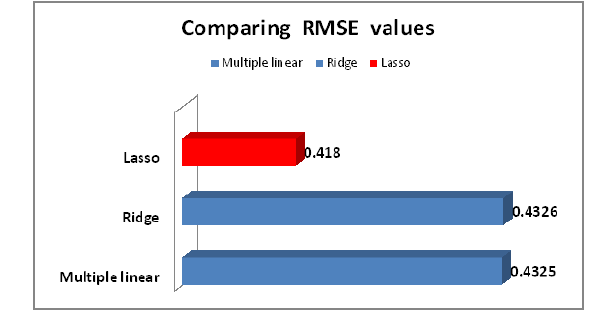
Figure 7. Comparing the algorithms using RMSE value